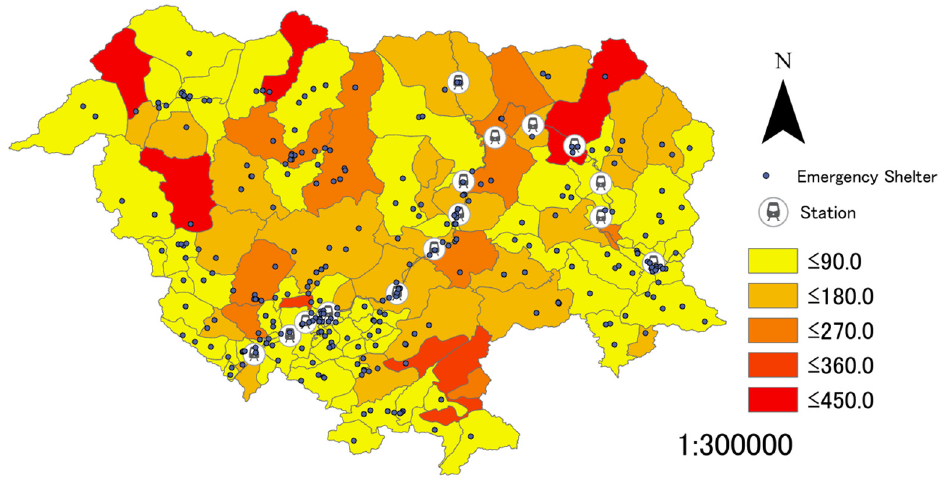
Figure 19. Result for Shobara City with the ratio of elderly population as a weighted coefficient.